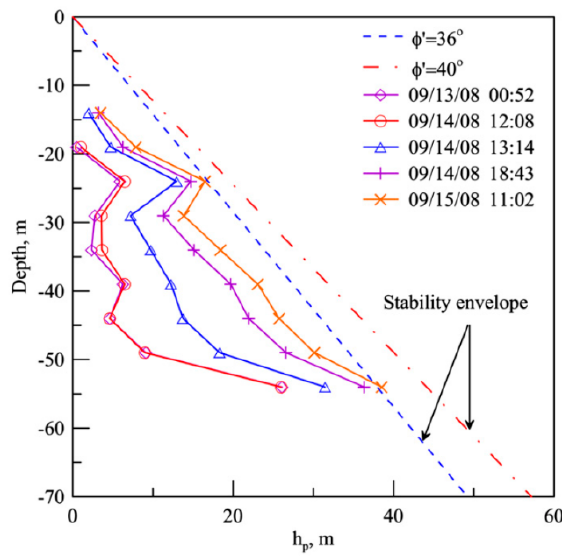
Figure 5. Profile of h p during typhoon Morakot [55].